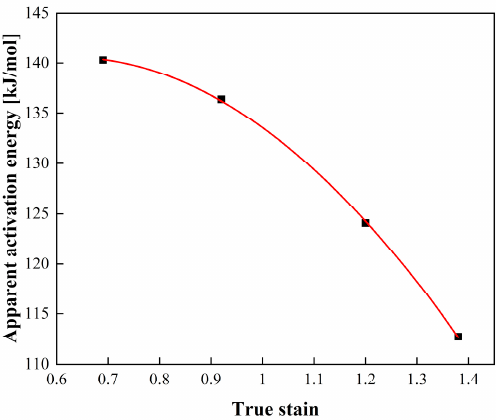
Figure 6. The variety of apparent activation energy ( Q ) with increasing strains of 0.69, 0.92, 1.20 and